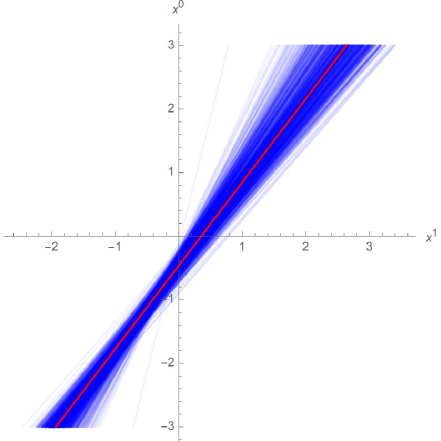
Figure 4 . Bundle of worldlines resulting from the random extraction of 1000 points from a Gaussian distribution in ( p, q ) centered in ( p, q ) = (1 , 1) . The red worldline corresponds to the center of the distribution, with ( p, q ) = (1 , 1) . Each worldline has an opacity of 0 . 05 .